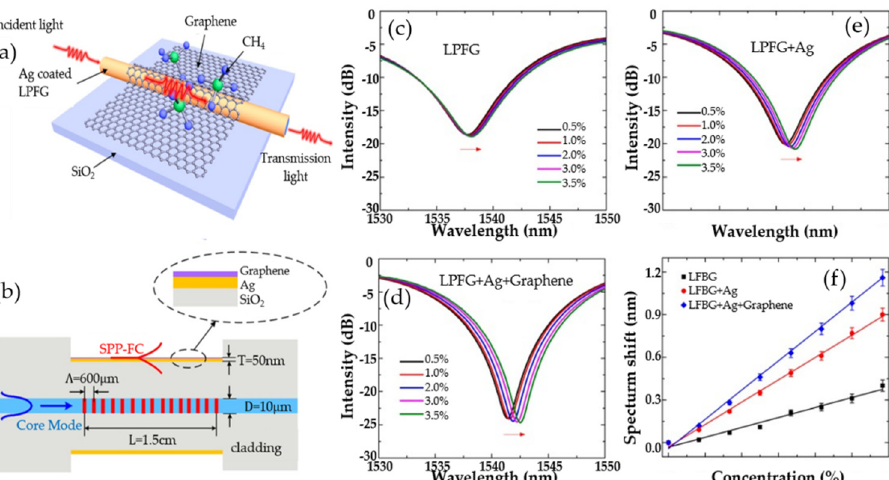
Figure 6. ( a ) The structure diagram of the graphene-based LPFG SPR sensor. ( b ) The sectional diagram of the graphene-based LPFG SPR sensor. ( c ) Transmission spectra of LFBG sensor. ( d ) Trans- mission spectra of graphene-based LFBG SPR sensor in different concentrations of methane gas. ( e ) Transmission spectra of Ag-coated LFBG SPR sensor. ( f ) Resonance wavelength shift versus concentration of methane. Reproduced from [94] with permission of the Multidisciplinary Digital Publishing Institute.